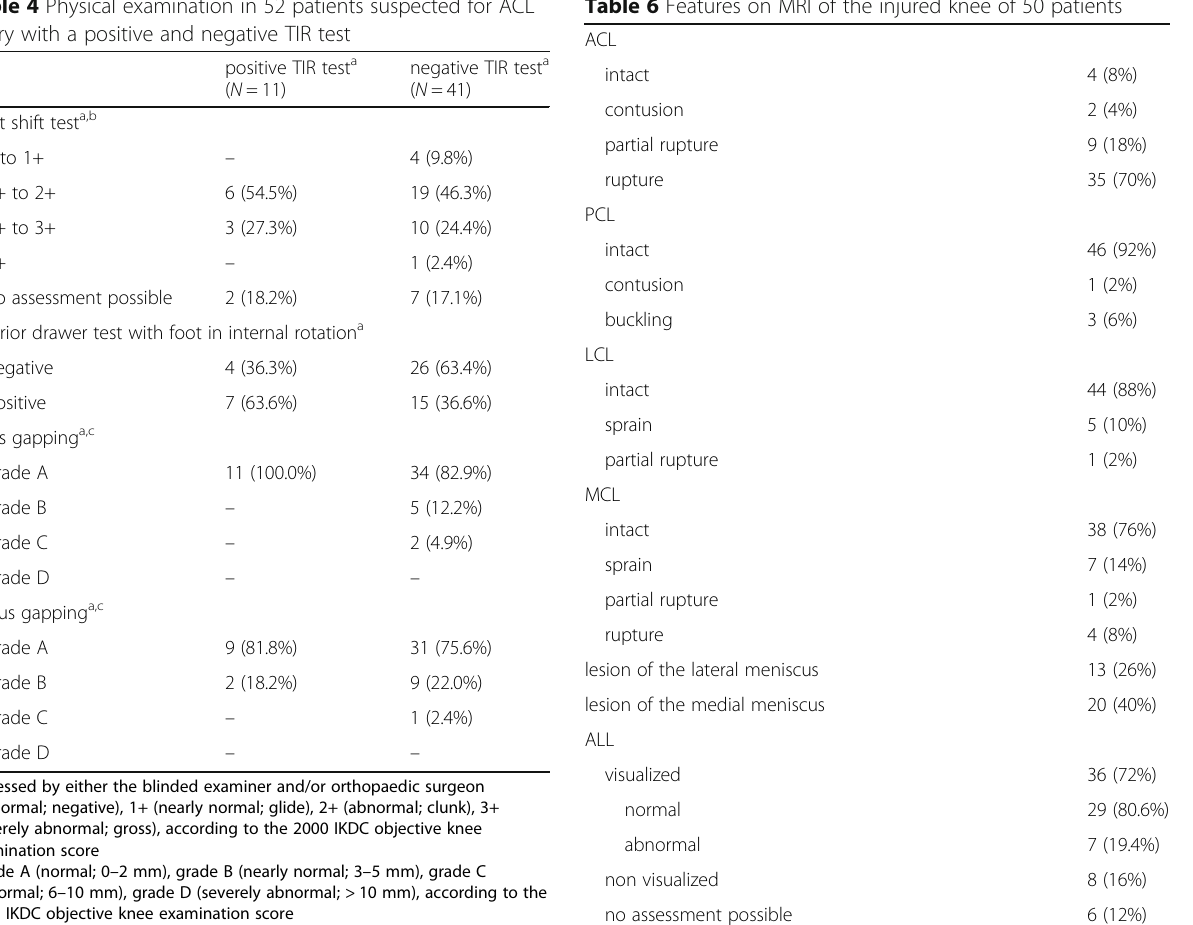
Table 6 Features on MRI of the injured knee of 50